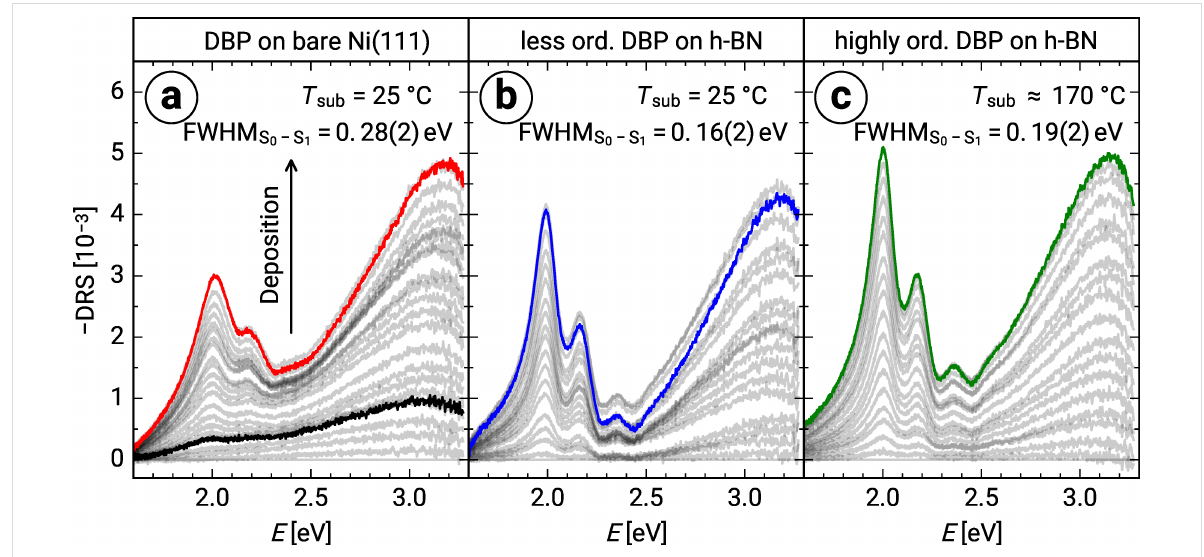
Figure 1: Film-thickness dependent evolution of the DR spectra of (a) DBP on bare Ni(111) as well as of DBP on h-BN/Ni(111) deposited at (b) room temperature and at (c) approx. 170 °C. Colored spectra correspond to a film thickness of 1 MLE. The black spectrum (about 0.25 MLE) is representa- tive of the strong electronic interaction between first-layer molecules and Ni(111). The full widths at half-maximum of the S 0 → S 1 transitions were de- termined by a fit of a Voigt function in combination with a linear